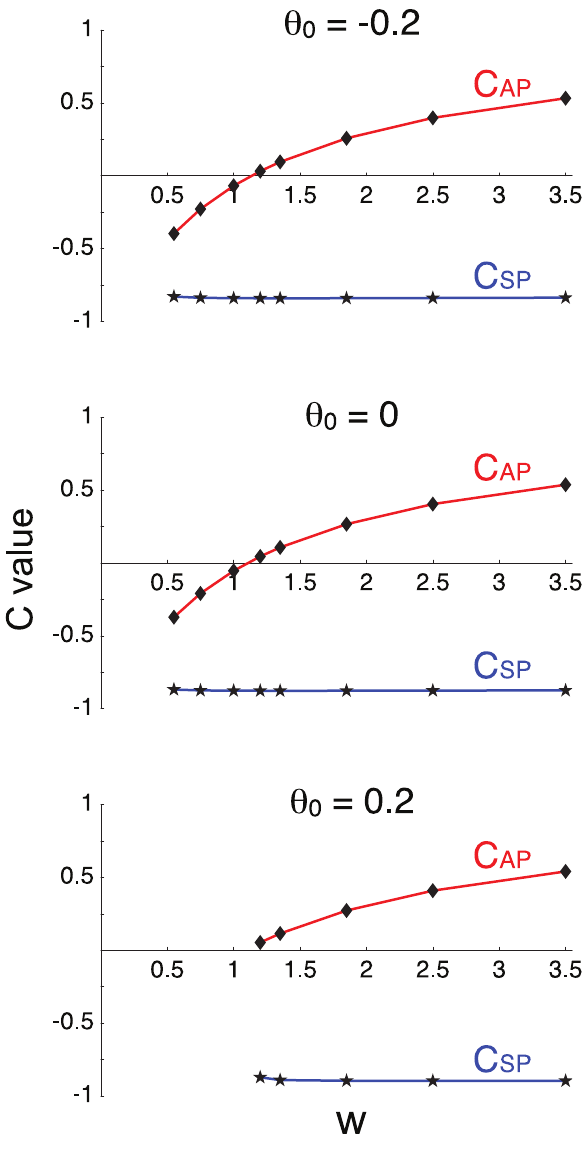
Figure 6. Variations of C AP and C SP with network connectivity and cell excitability (for t h / t s = 1, g = 1). C AP increases with increased synaptic connectivity, as would be expected from the correlative measure (Eq 4), with equal contributions from both processes (C AP =0) when (w/g) ( t h / t s ) =1. In contrast, C SP is always close to -1, the subtractive feedback process sets the length of the silent phase regardless of the value of w. Finally, both C AP and C SP are unaffected by changes in h 0 , showing that cell excitability does not influence which process controls episodic activity.